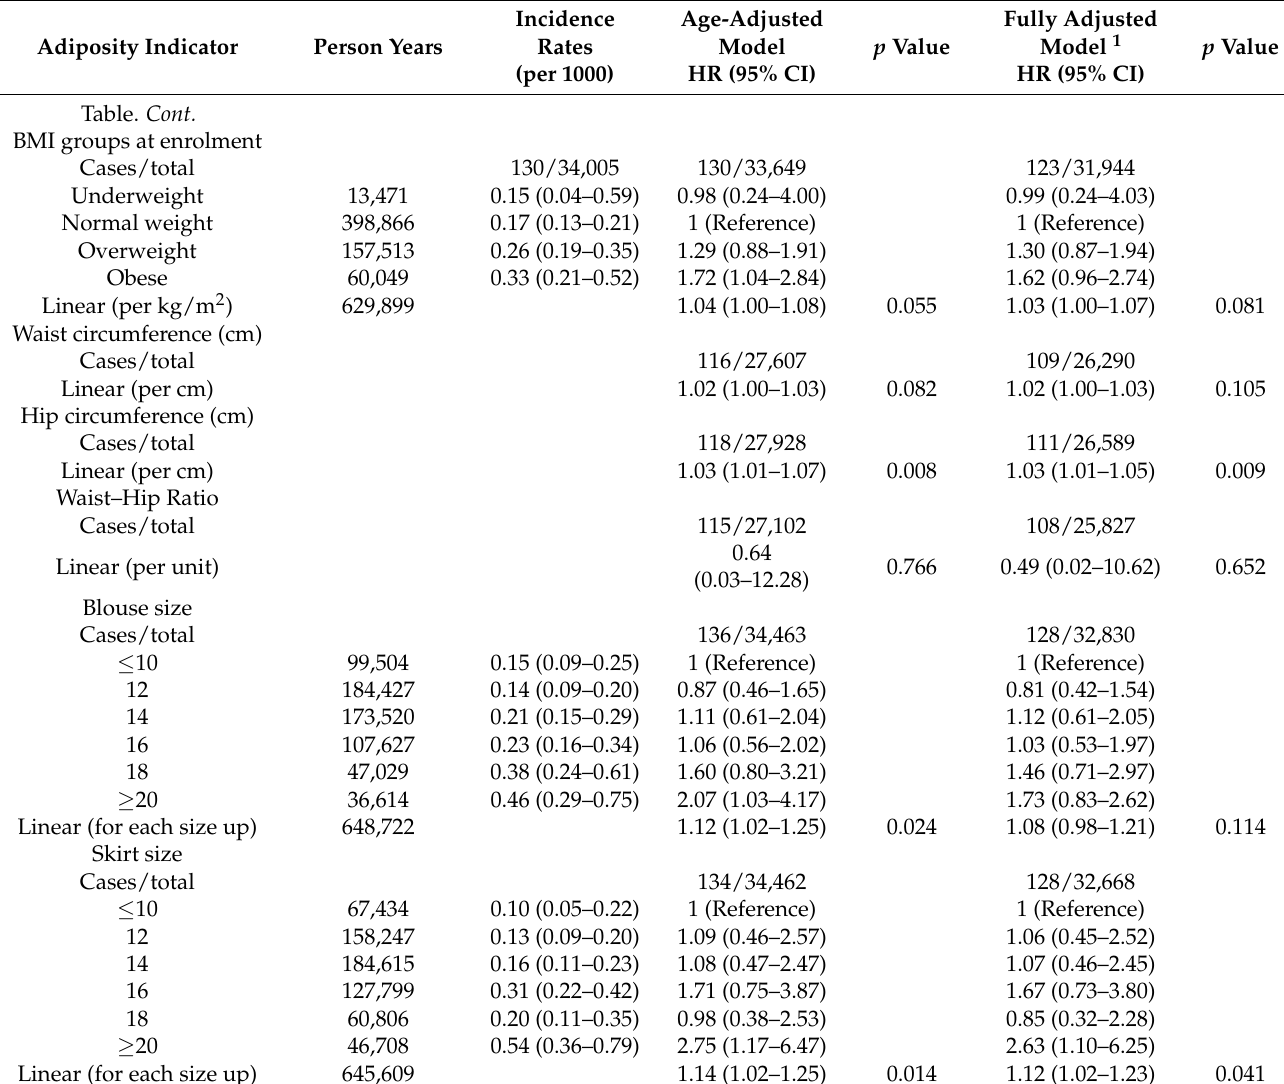
Table 3. Adiposity indices and hazard ratio (HR) (95% CI) for pancreatic cancer in the UKWCS.